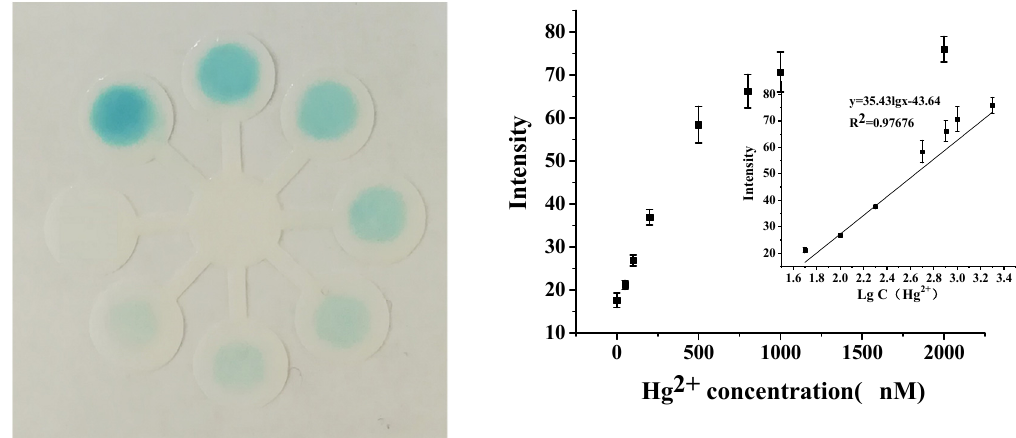
Figure 5. The image of detection of Hg 2+ and calibration curve of colorimetric detection.